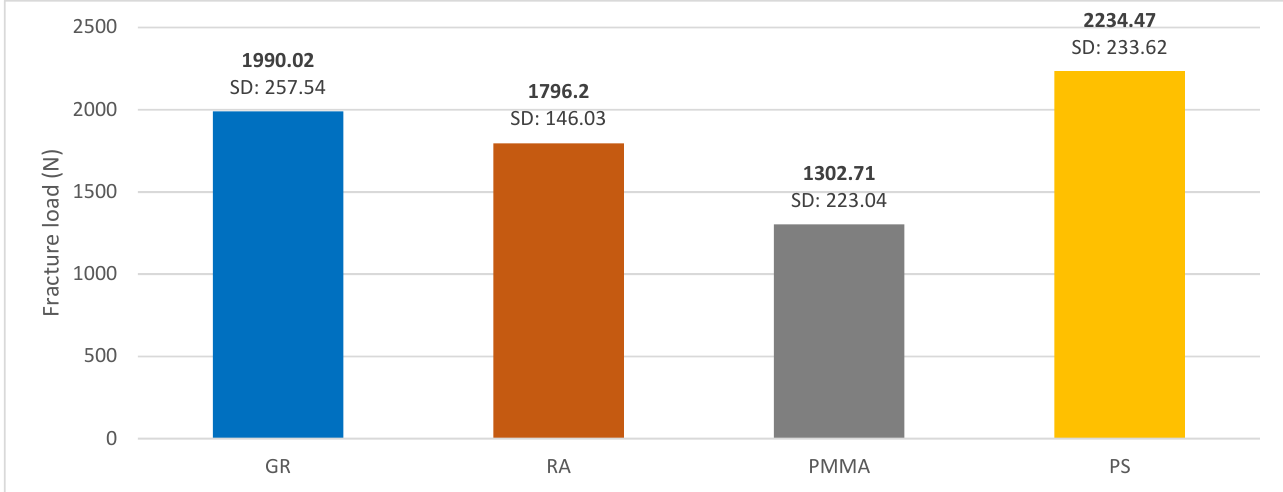
8 of 15 Table 3. Paired comparison test summary. Group1-Group 2